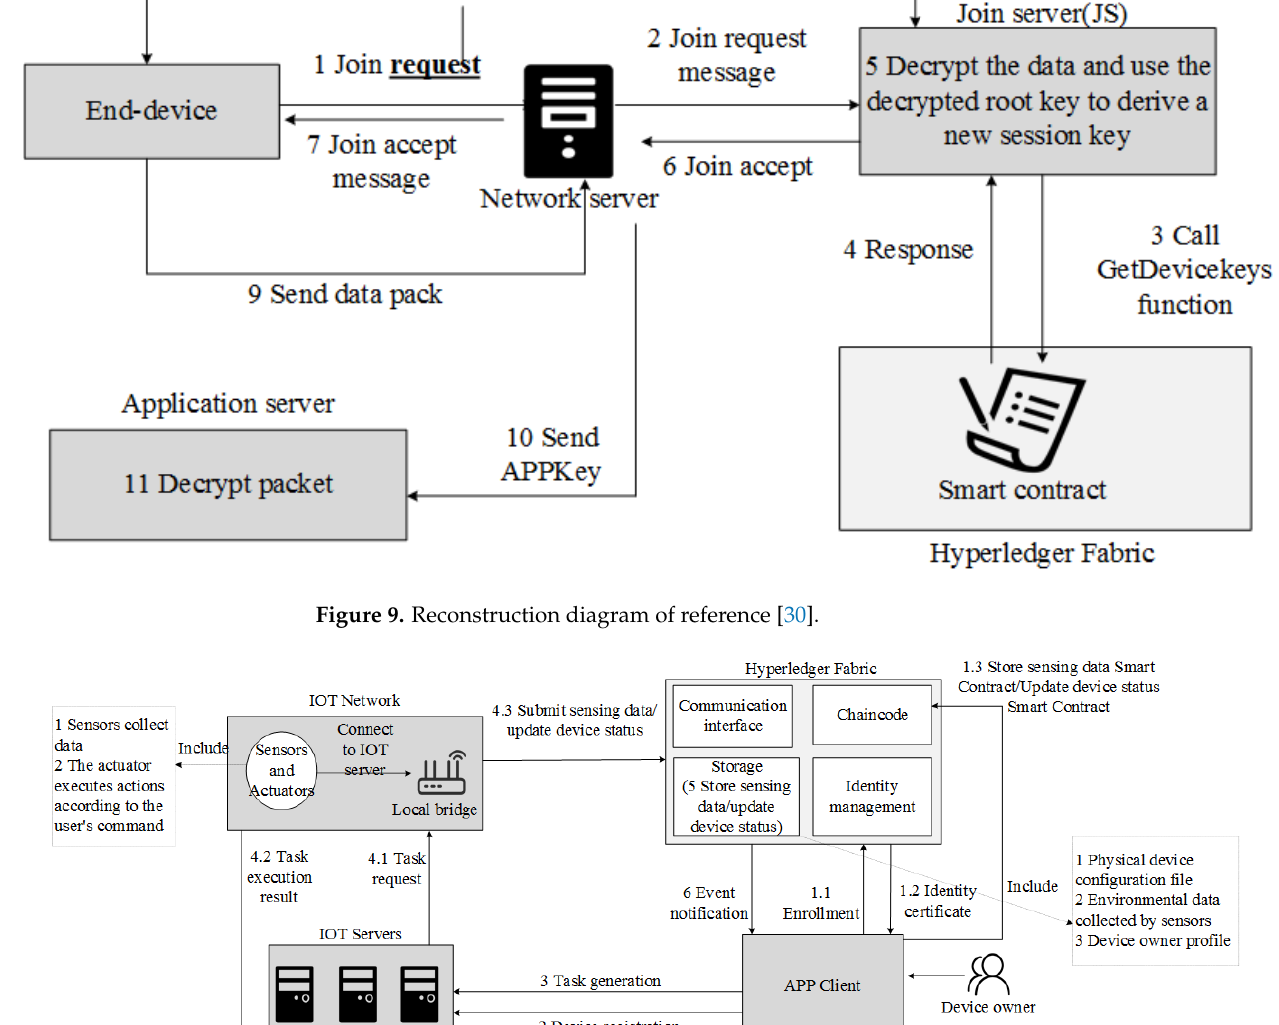
Figure 11. Reconstruction diagram of reference [32]. Figure 12. Reconstruction diagram of reference [33].